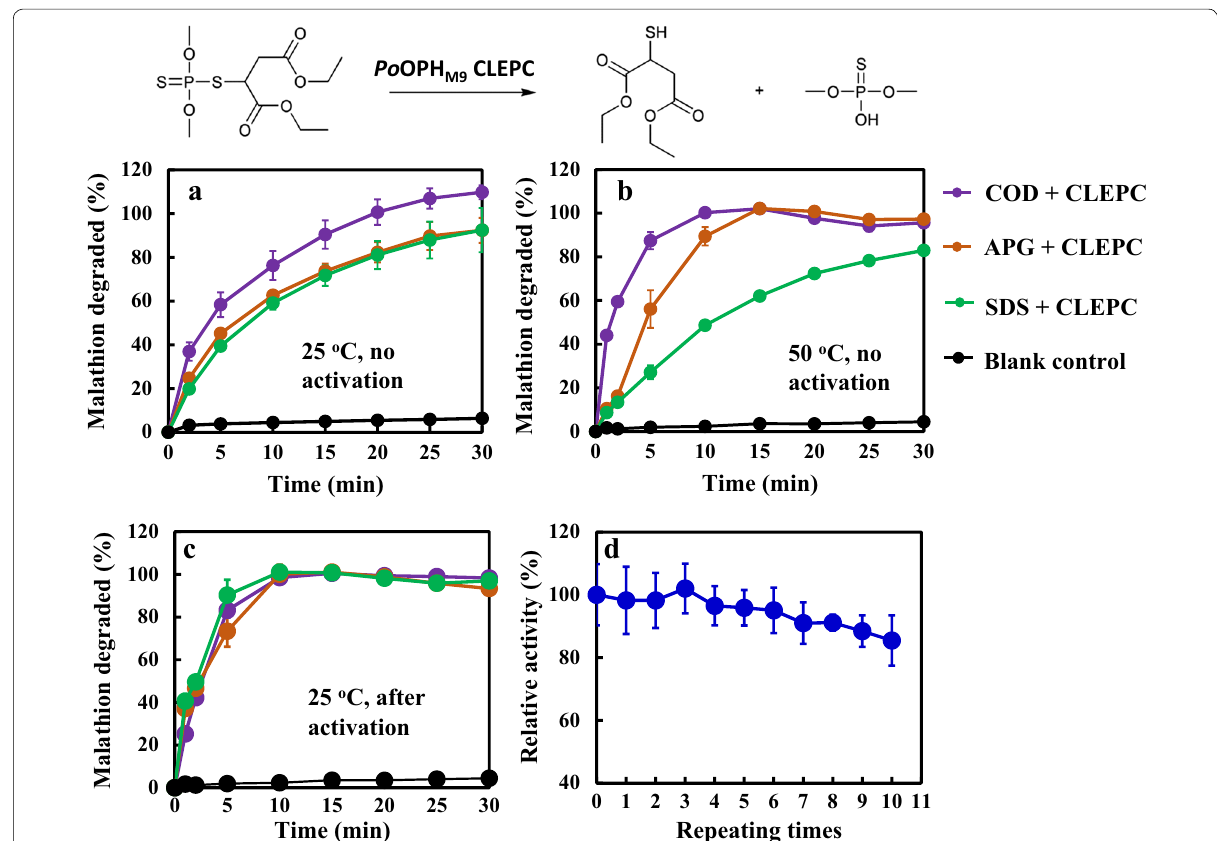
Fig. 4 Degradation of 0.15 mM malathion by Po OPH M9 CLEPC in the presence of 0.1% (v/v) COD, APG and SDS. The experiments were performed immediately after the addition of detergents at 25 °C ( a ) and 50 °C ( b ). c The degradation was performed at 25 °C using Po OPH M9 CLEPC that was incubated with detergents for 2 h in advance. d Recycling CLEPC for malathion degradation. The relative activity of Po OPH M9 CLEPC was measured at 25 °C after each cycle for 10